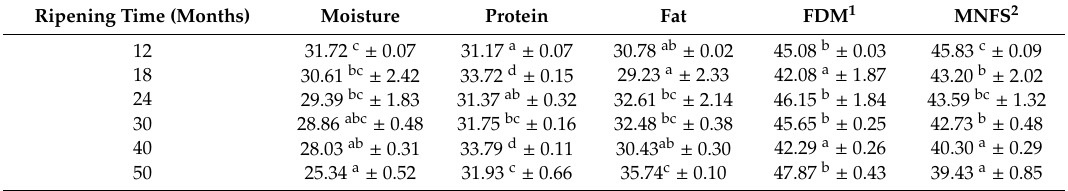
Table 1. Gross composition (g / 100 g) of Parmigiano Reggiano cheeses ripened from 12 to 50 months. Ripening Time